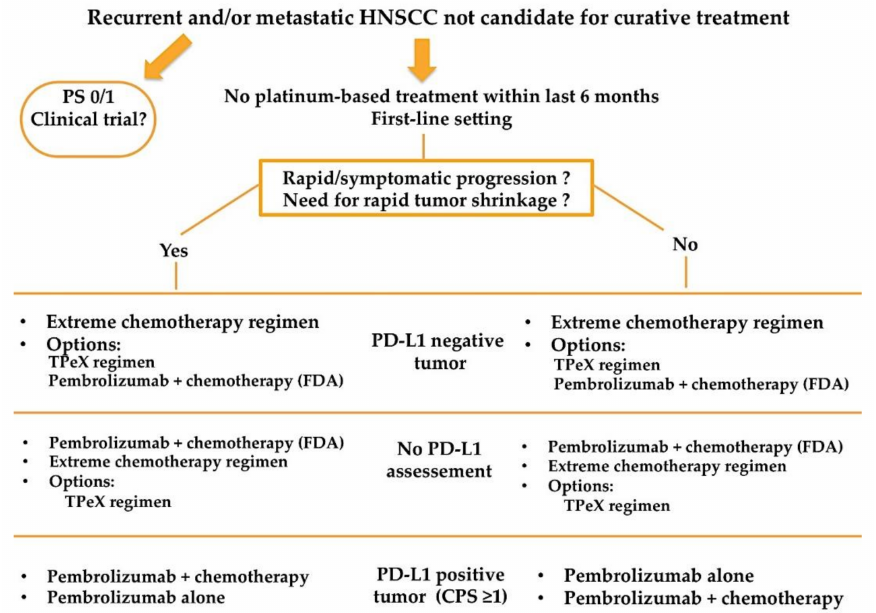
Figure 1. Proposed treatment algorithm in the first line setting for patients with recurrent and/or metastatic HNSCC.